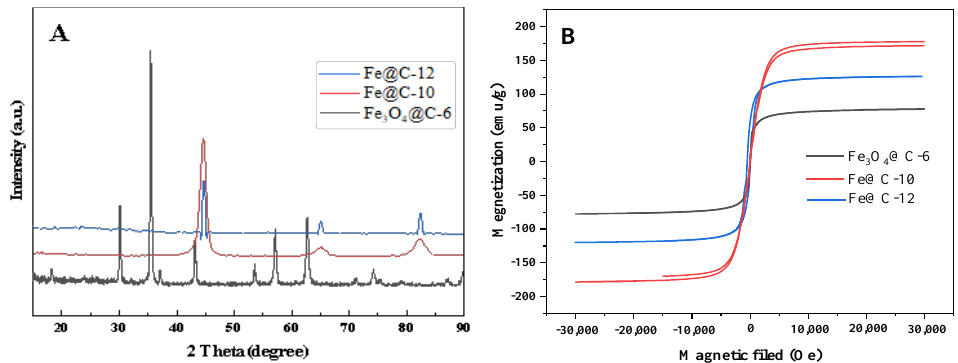
Figure 5. XRD ( A ) and VSM ( B ) curves of Fe 3 O 4 @RF microsphere carbonization products with different shell thicknesses.